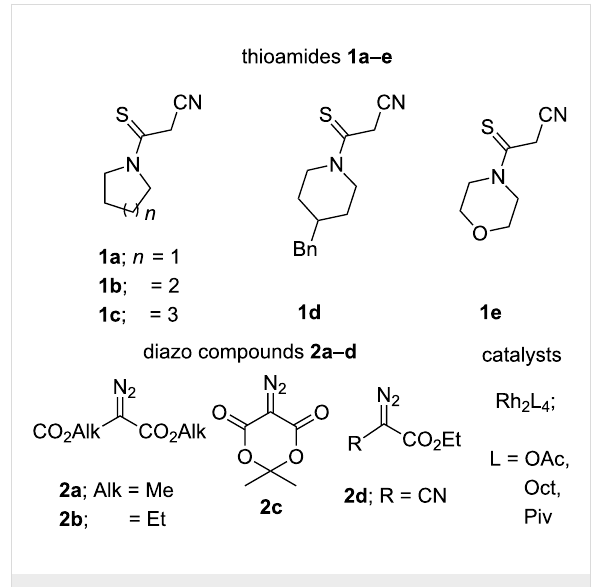
Figure 1: Thioamides 1a – e , diazoesters 2a – d and Rh(II)-catalysts used in the project.